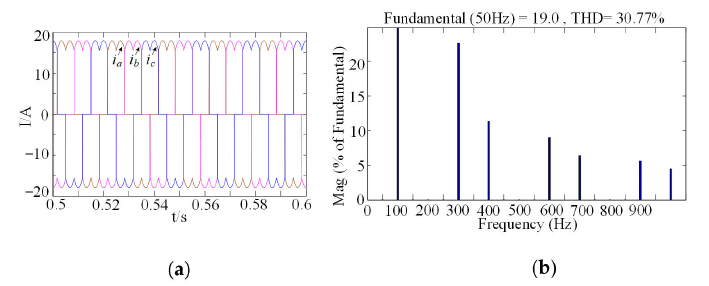
Figure 13. Uncompensated waveforms: ( a ) current of power grid; ( b ) THD of B-phase current.